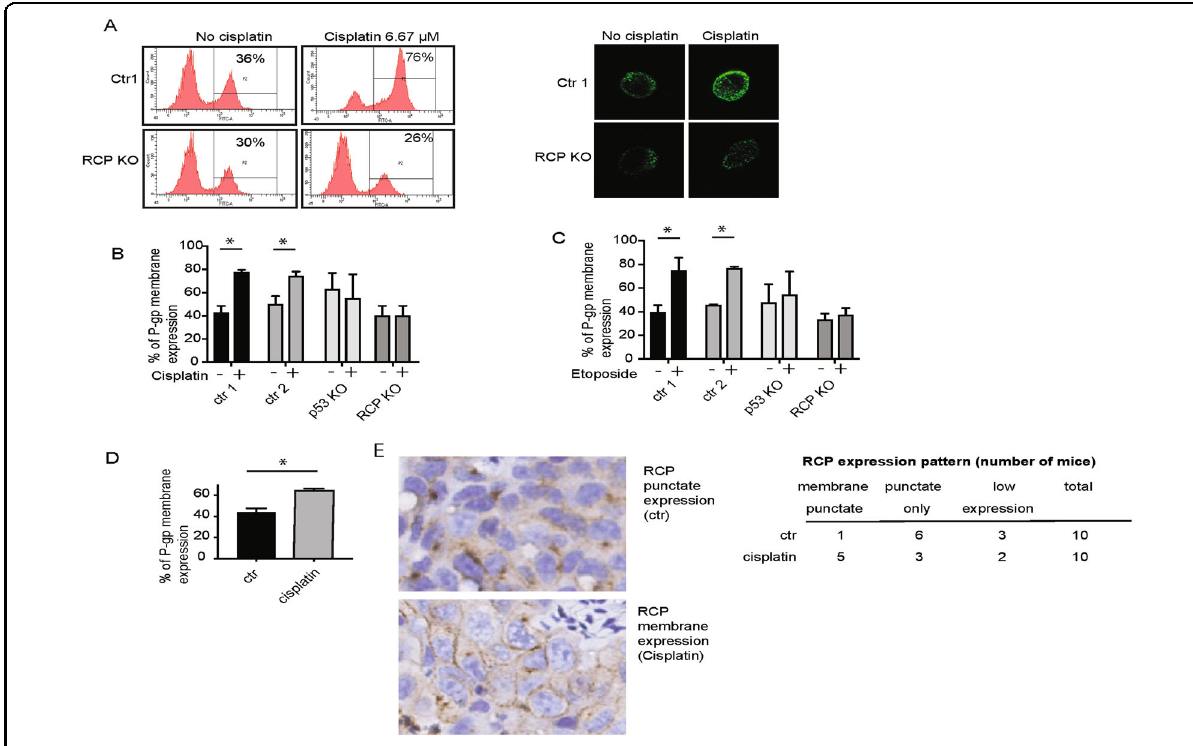
Fig. 5 Plasma membrane expression of P-gp is enhanced in mutant p53 cells upon cisplatin treatment. A P-gp plasma membrane expression was evaluated by fl ow cytometry of the A431 control and RCP KO cells treated with cisplatin (6.7 µM for 2 h) (left). Fluorescent images of individual cells are shown on the right, taken after fl ow cytometry. B Quanti fi cation of P-gp plasma membrane expression in A431 ctr1, ctr2, RCP KO and p53 KO cells upon cisplatin treatment (6.7 µM for 2 h). Statistical differences were measured using a one-way ANOVA, multiple testing ctr1 ± cisplatin P = 0.0001, ctr2 ± cisplatin P = 0.0108, two-sided. Error bars indicate SD of average values of three independent experiments. C Quanti fi cation of P-gp plasma membrane expression in A431 ctr1, ctr2, RCP KO and p53 KO cells upon etoposide treatment (3.4 µM for 2 h). Statistical differences were measured using a one-way ANOVA, multiple testing ctr1 ± etoposide P < 0.0001, ctr2 ± etoposide P = 0.0002. Error bars indicate SD of average values of three independent experiments. D P-gp plasma membrane expression in HCT116 p53 248W/- in the presence and absence of cisplatin (6.7 µM for 2 h). Statistical differences were measured using a t -test, two-sided P = 0.0011. Error bars indicate SD of average values of three independent experiments. E RCP staining in A431 control xenografts from mice exposed to cisplatin or a vehicle control. Numbers of mice that displayed a membrane staining (including punctate staining), punctate staining only, or low RCP expression are indicated on the